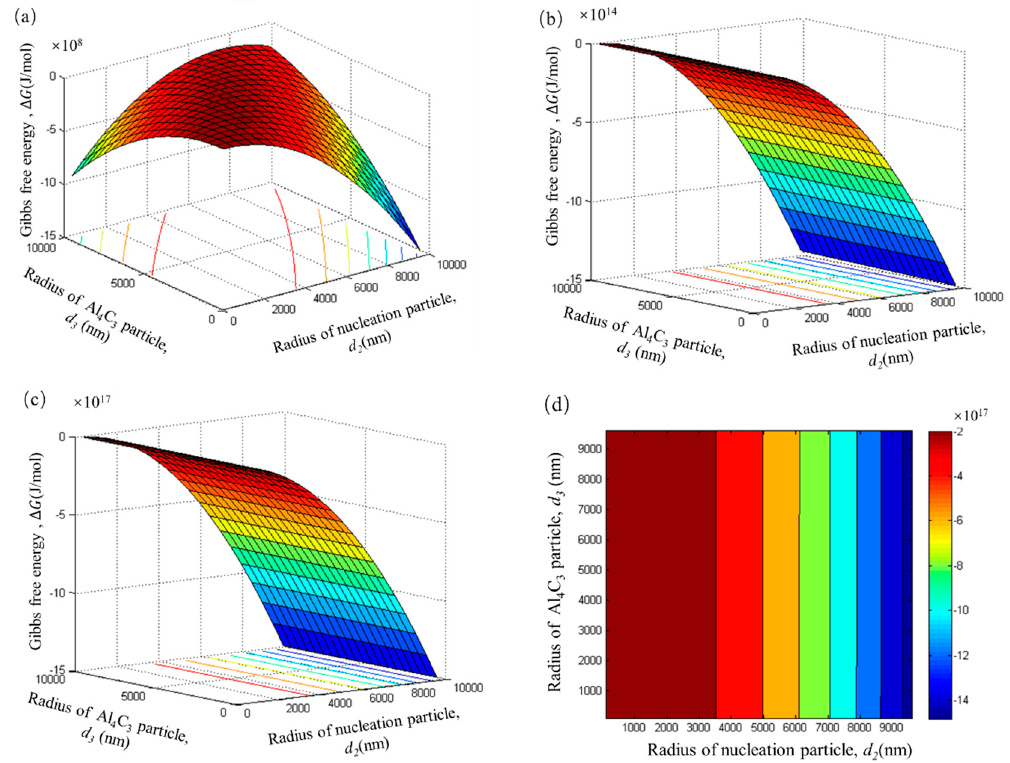
Figure 10. The Gibbs free energy of the Al 4 C 3 cluster particles with different number tiny Al 4 C 3 particles. The number of tiny Al 4 C 3 particles is calculated by Equation (6). ( a ) n = 1, ( b ) n = 100, ( c ) n = 1000, ( d ) the contour map of n = 1000.